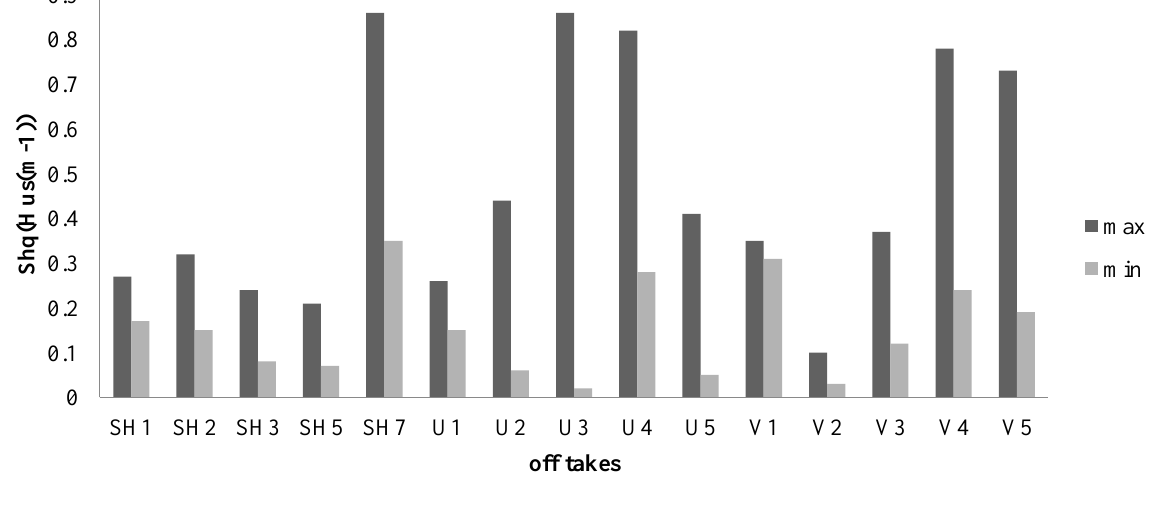
Fig. 5 Offtake sensitivity of delivery to absolute deviation of water depth Index (Real